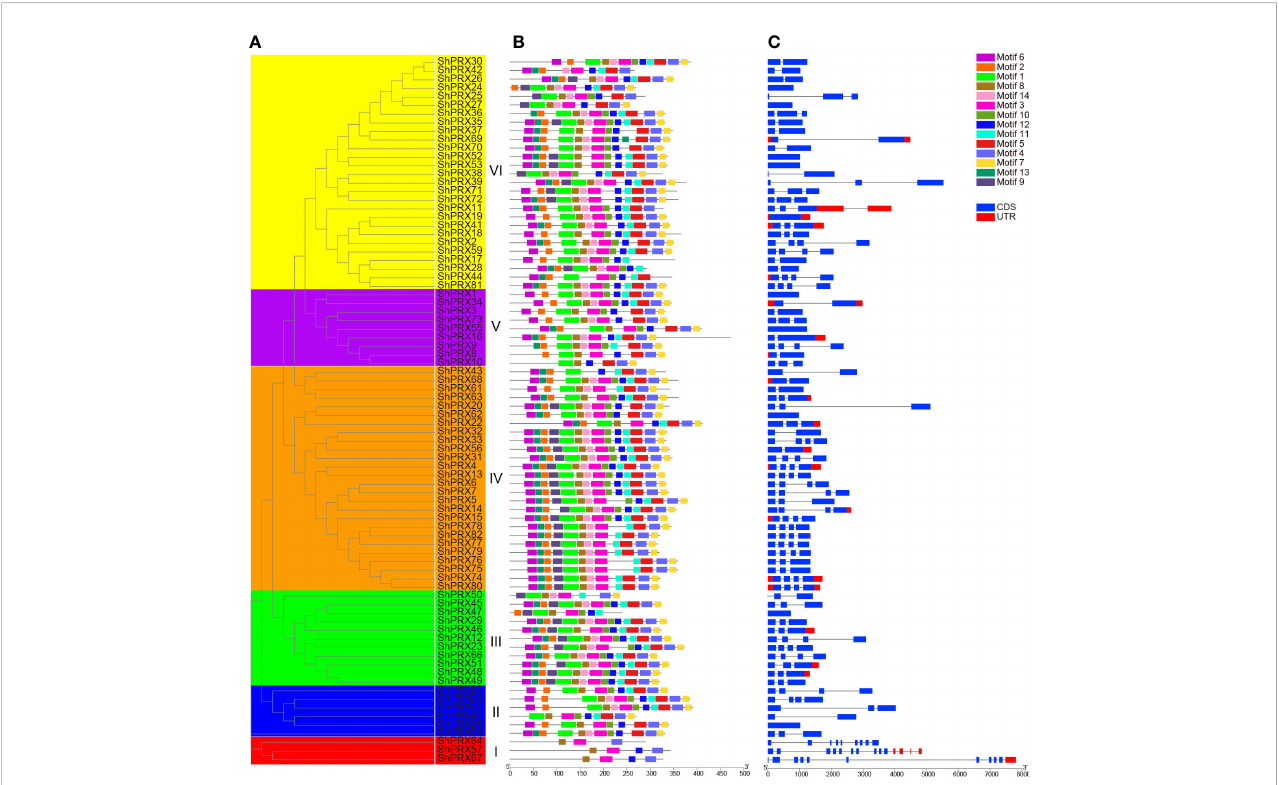
FIGURE 3 Analysis of gene structure and conserved motif of the PRX gene family in each group of sugarcane. (A) Phylogenetic tree of the ShPRX proteins. (B) Motif composition in the ShPRX proteins. (C) Gene structure of the ShPRXs